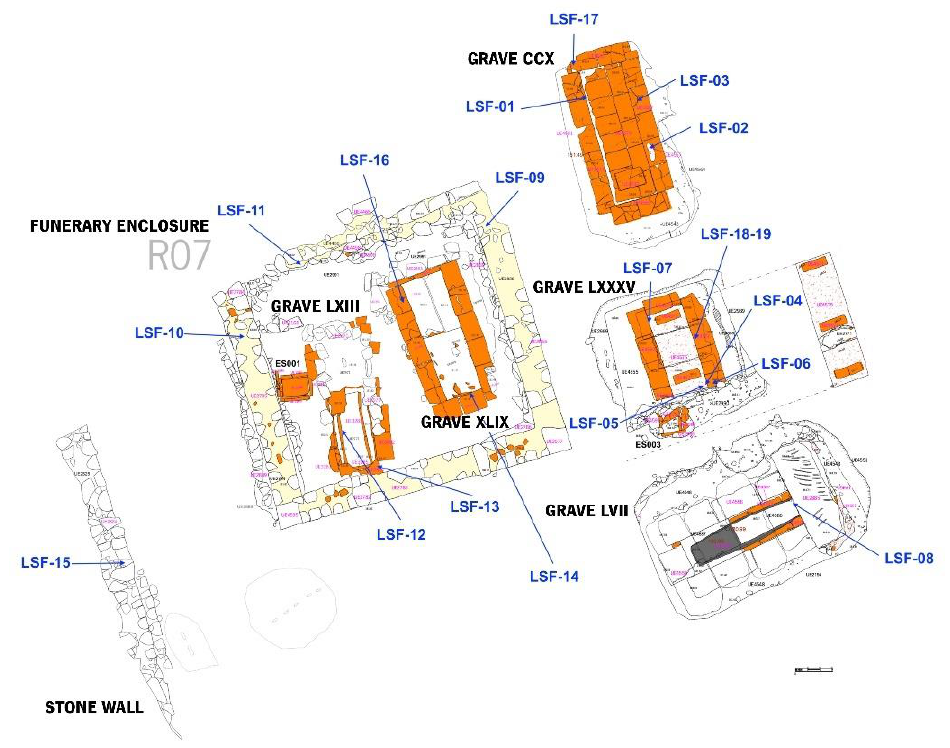
Figure 3. Schematic representation of the funerary nucleus and sampling areas. Adapted from